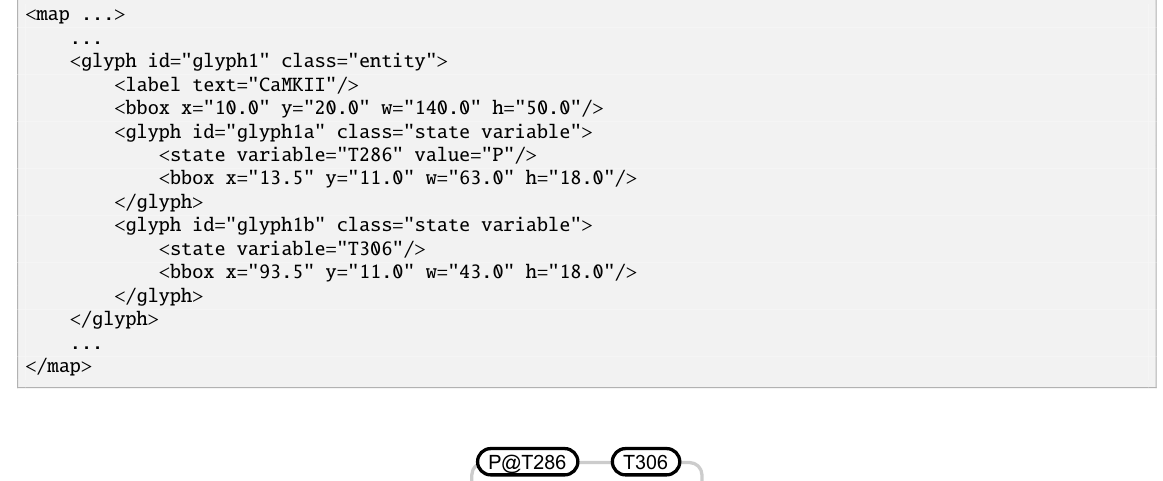
Figure 18: Visual representation of two State s on a Glyph of the class macromolecule .